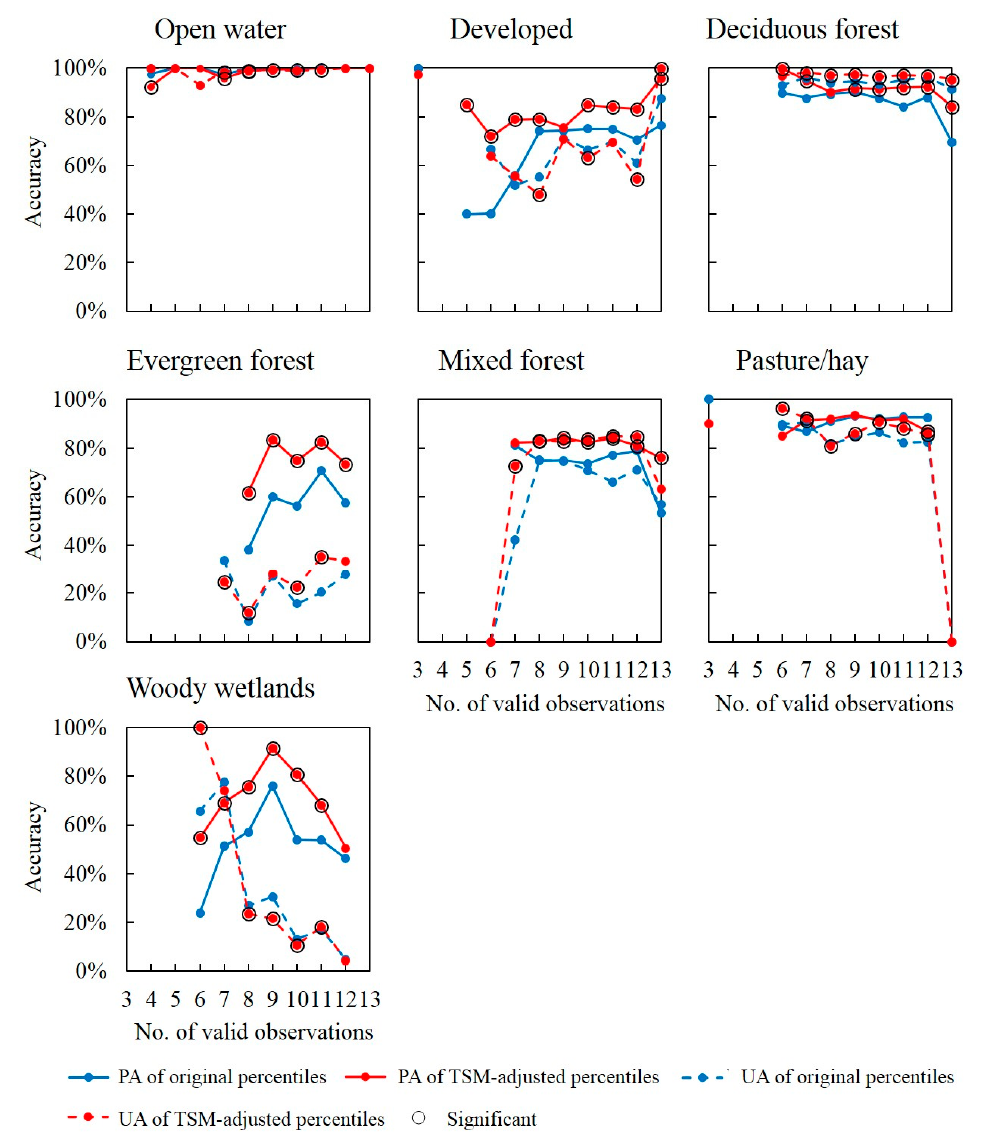
Figure 12. The average PA and UA of each land cover type against the number of valid observations in New York study area. Note that the black circles indicate that the accuracies obtained using the TSM-adjusted percentiles are significantly (at the 5% level) different from the accuracies obtained using the original percentiles.